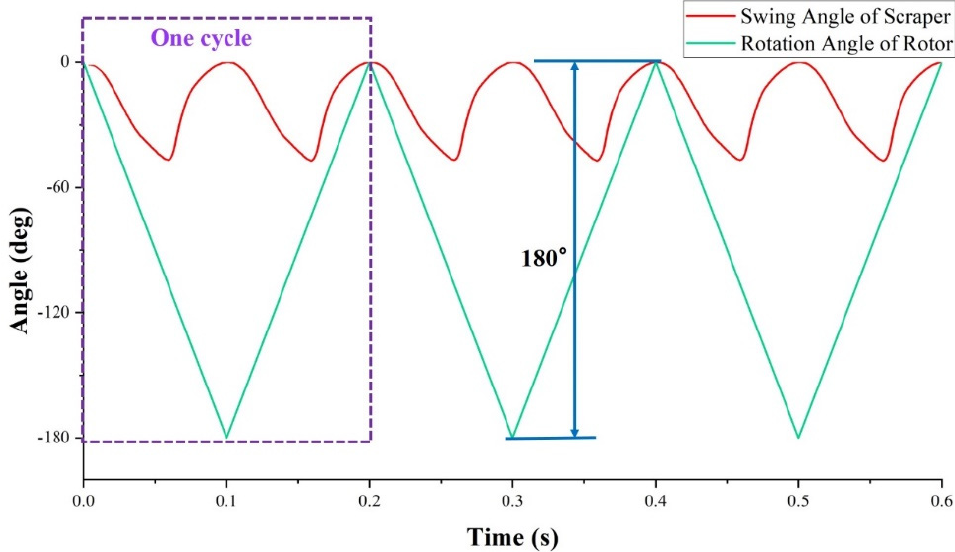
Figure 5. Rotor and swing scraper rotation angle comparison curve.